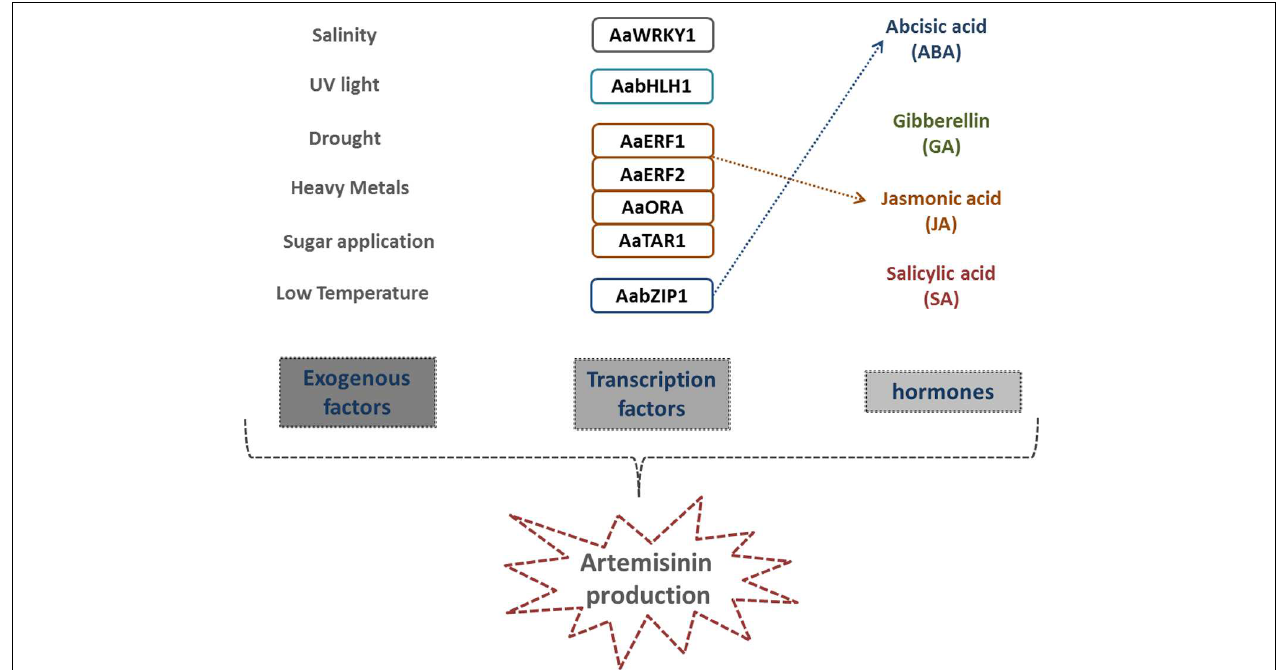
FIGURE 4 | Essential factors promoting AN biosynthesis. Endogenous and exogenous factors that positively affect AN biosynthesis. Different abiotic factors inducing plant defense, trichome proliferation and, consequently, AN production. Seven transcription factors have been identified so far in the positive regulation of any of the AN pathway enzymes. Plant hormones ABA, GA, JA, and SA also positively affect both trichome proliferation and artemisinin biosynthesis. Dashed, colored arrows indicate TFs that directly regulate hormone biosynthetic pathways.